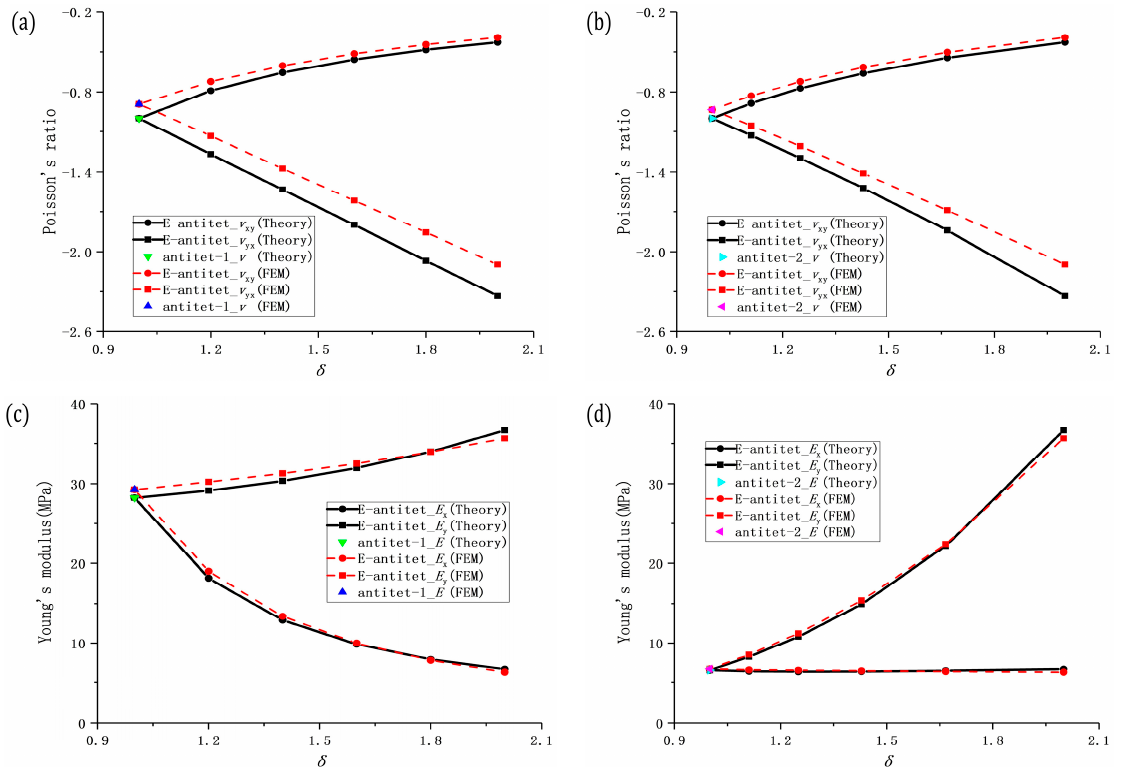
Figure 5. Trends of Poisson’s ratio and Young’s modulus for E-antitet at different δ : Analytical and numerical solutions of Poisson’s ratio for ( a ) antitet-1 and ( b ) antitet-2 to E-antitet base cell; analytical and numerical solutions of Young’s modulus for ( c ) antitet-1 and ( d ) antitet-2 to E-antitet base cell.